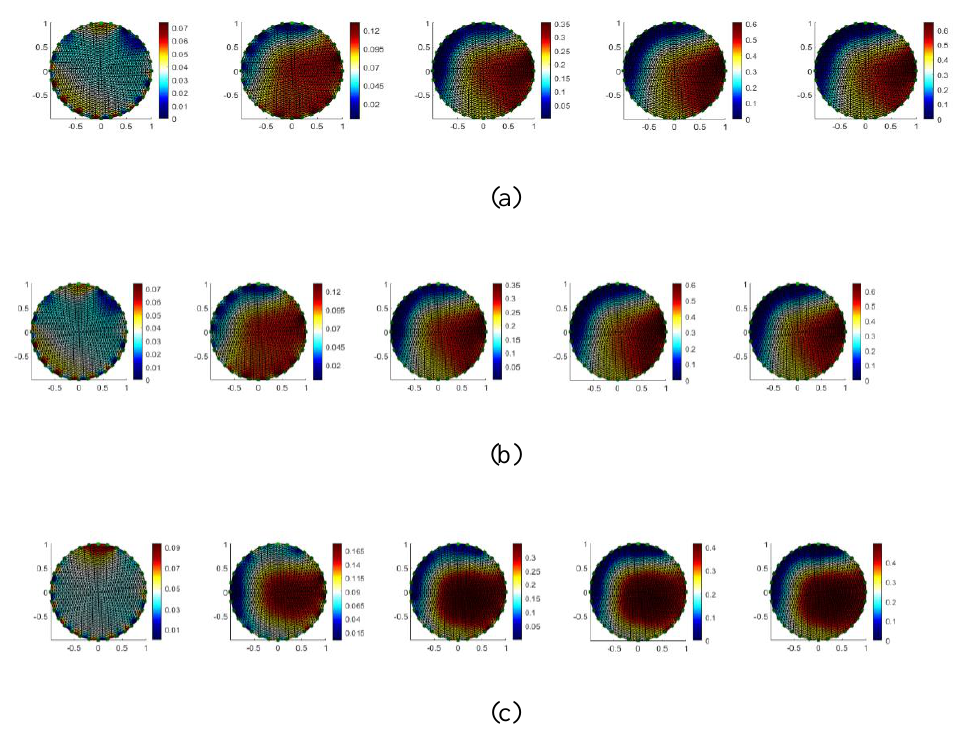
Figure 6. EIT images for RF excited AuNPs at 13.56 MHz: ( a ) Cline Scientific (CS) with 57.5% conductivity variation with respect to a reference based on di ff erence imaging; ( b ) Sigma Aldrich (SA) with 54.3% conductivity variation with respect to a reference based on di ff erence imaging; ( c ) PBS with 40.2% conductivity variation with respect to reference based on di ff erence imaging. The axis is spatially coordinated to the transversal cross section of the well containing the sample, the dimensions are in cm. The diameter of the circle of electrodes is 2.8 cm. The color bar is % conductivity change.